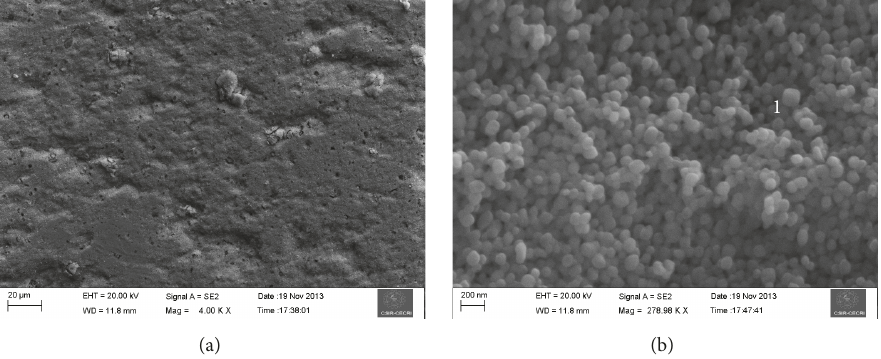
Figure 3: (a) Lower magnification image of SrTiO 3 sample before exposure to hot corrosion and (b) higher magnification image of (a). EDX analysis was done on the surface of (b) at region 1 (corresponding to SrTiO 3